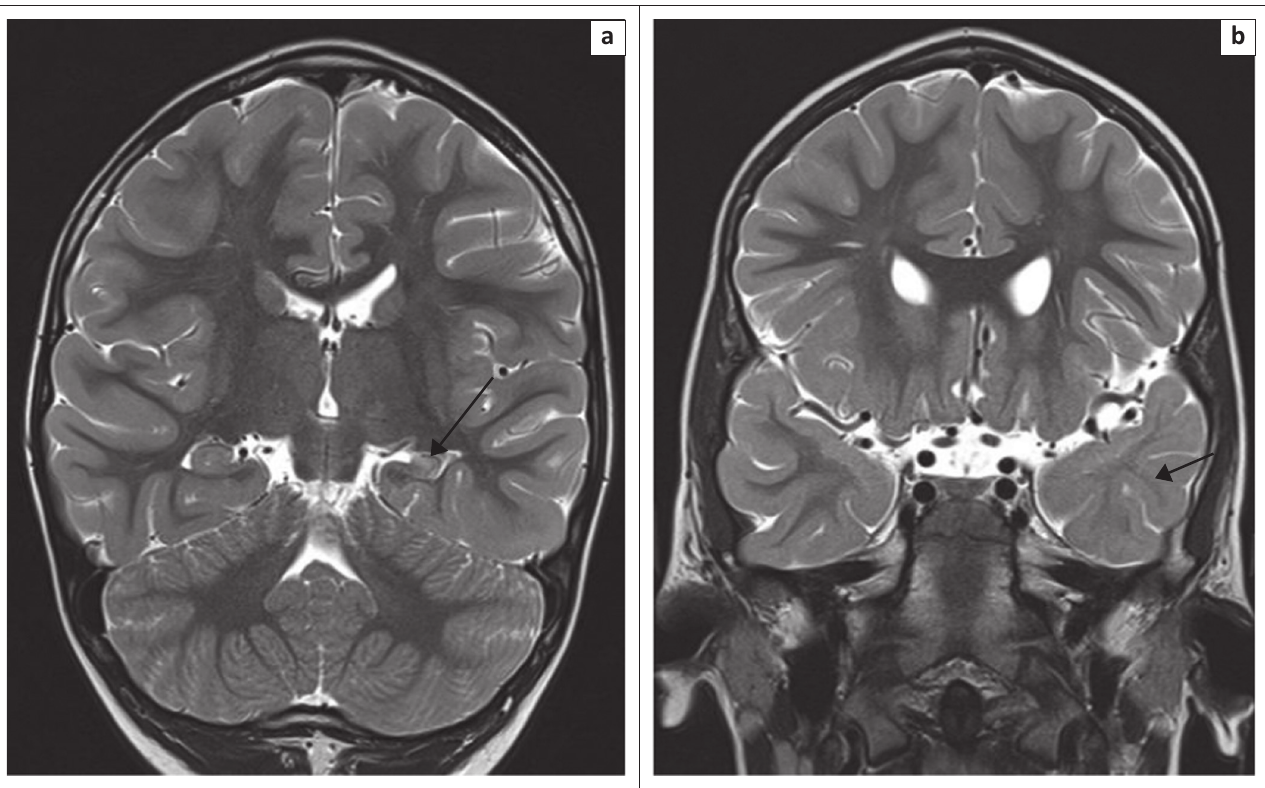
FIGURE 4: Three-year-old girl with mesial temporal sclerosis. Coronal T2W images demonstrate T2 prolongation and loss of volume within the left hippocampus (a) (arrow). Note also the blurring of the gray and white matter in the left temporal lobe (b)